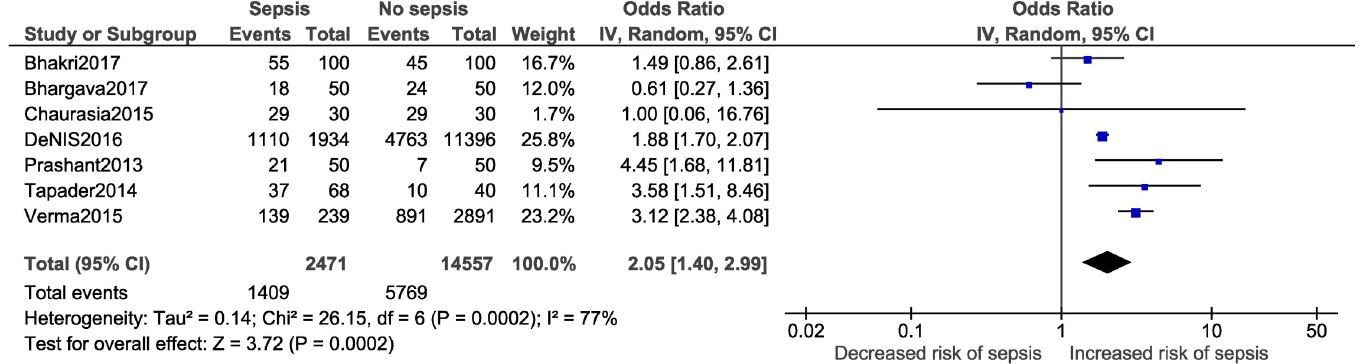
Fig 8. Forest plot showing a random-effects meta-analysis of neonates, with and without sepsis, born to mothers who delivered at < 37 weeks of gestation.